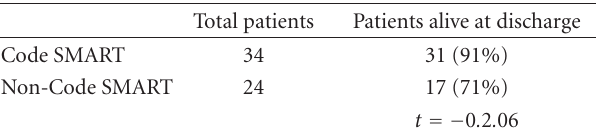
Table 4: Survival at discharge—Code SMART versus Non-Code SMART.